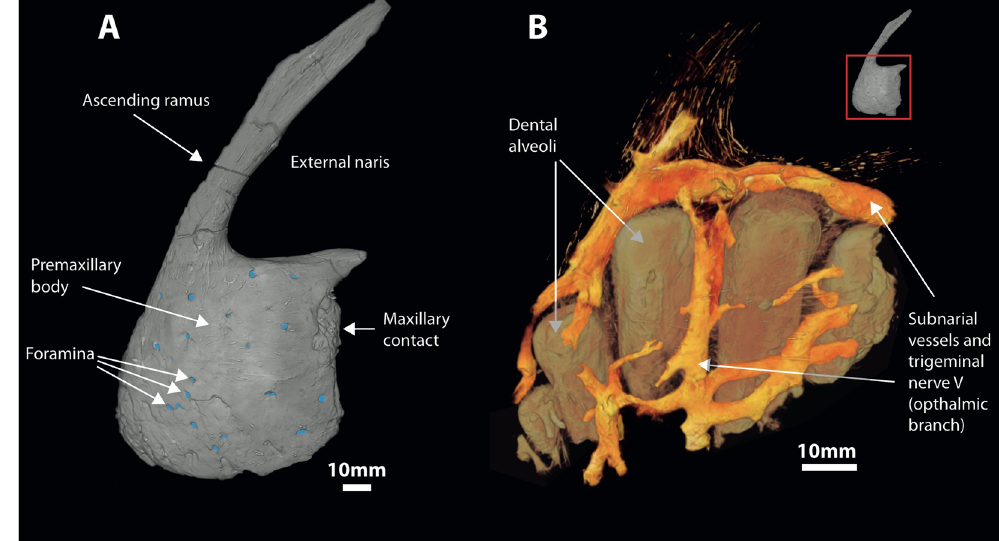
Figure 1. Complex anastomosing neurovasculature surrounding infilled dental alveoli of the premaxilla of Neovenator . ( A ) Volume rendering of left premaxilla in lateral view with foramina highlighted (blue). ( B ) Volume rendering of infilled